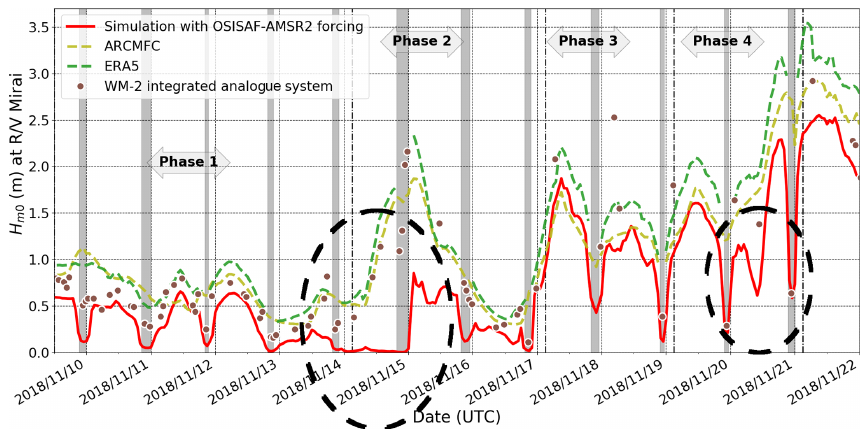
Figure C1. The TodaiWW3-ArCS H m estimates using the OSISAF-AMSR2 SIC as forcing interpolated at R/V Mirai positions are shown 0 during the MIZ transect observation. The figure also shows the WM-2 data when R/V Mirai ship speed was < 2ms − 1 . Two independent predictions from ERA5 ECWAM and the ARCMFC wave model are also shown. The dashed black circles indicate times when the erroneous SIC forcing caused inaccurate estimates of H m at the R/V Mirai position. Grey highlighted times indicate when the vessel was in ice-covered 0 seas based on the ice navigator’s logs: from the first (known) encounter of sea ice to the ship proceeding to the ice-free water.